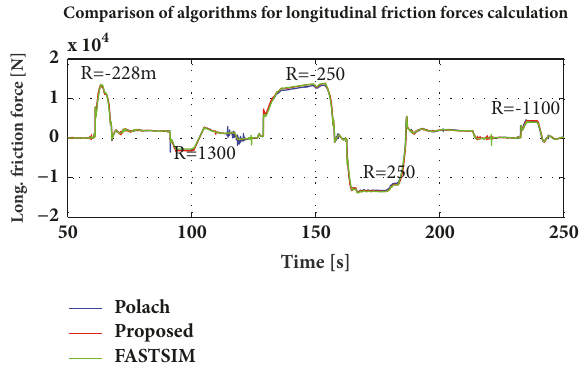
Figure 12: Longitudinal friction forces obtained on a section of the Aosta–Pr´e-Saint-Didier track.